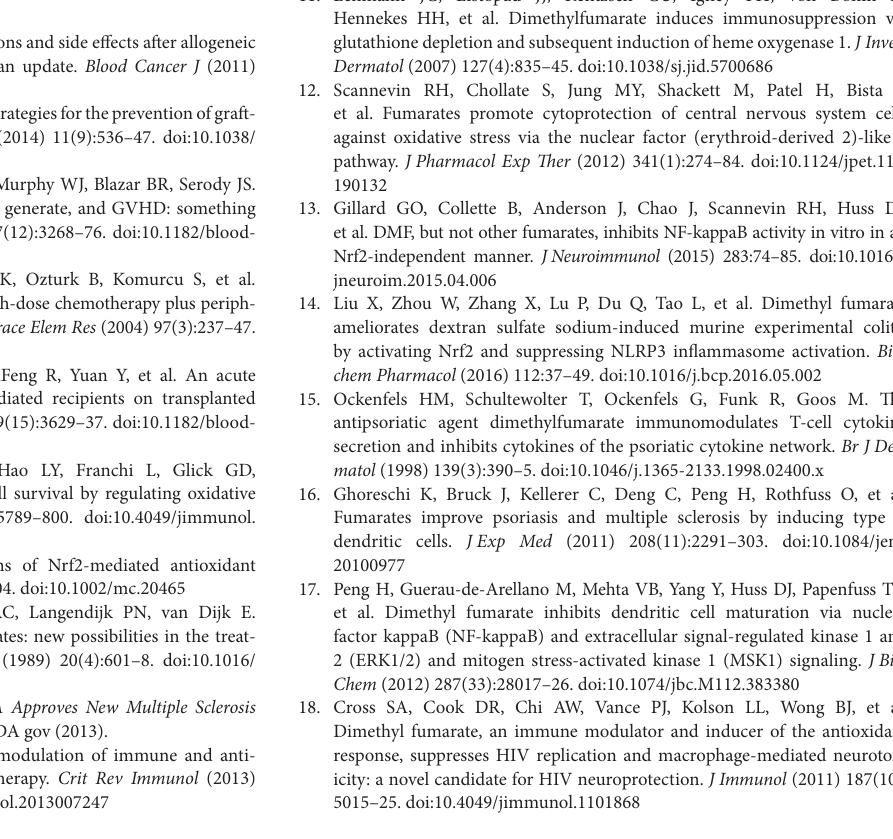
FigUre s1 | DMF inhibited T cells proliferation and DCs maturation in vitro . CD3 + T cells were isolated from spleen of C57BL/6 mice and activated by plate bound anti-CD3 (5 µg/ml) and anti-CD28 (1 µg/ml) in the presence of DMF or DMSO for 48 h. cell proliferation was measured by 3 H-TdR (a) , Data shown are mean ± SD. *** P < 0.001, compared with DMSO group (ANOVA with Dunnett’s test). BM-derived DCs were generated and expanded from BALB/c mice with GM-CSF (10 ng/ml) and IL-4 (10 ng/ml). DCs were treated with DMF or DMSO for 24 h in the present or absence of LPS (1 µg/ml), CD80, CD86, and CD40 on the DCs were examined by FACS (B–D) . Cytokines IL-6, TNF- α , IFN- γ in the supernatants were collected and measured by ELISA (e–g) . Data shown are mean ± SD. *** P < 0.001 compared with LPS group (ANOVA with Dunnett’s